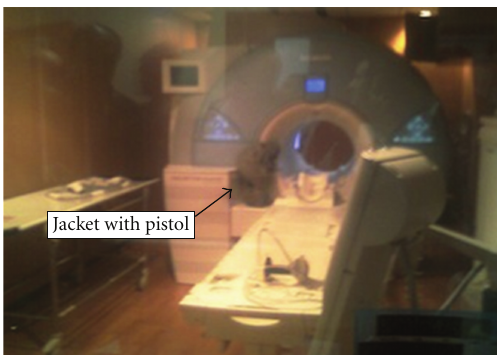
Figure 1: Photograph showing jacket with pistol caught in the magnetic bore.